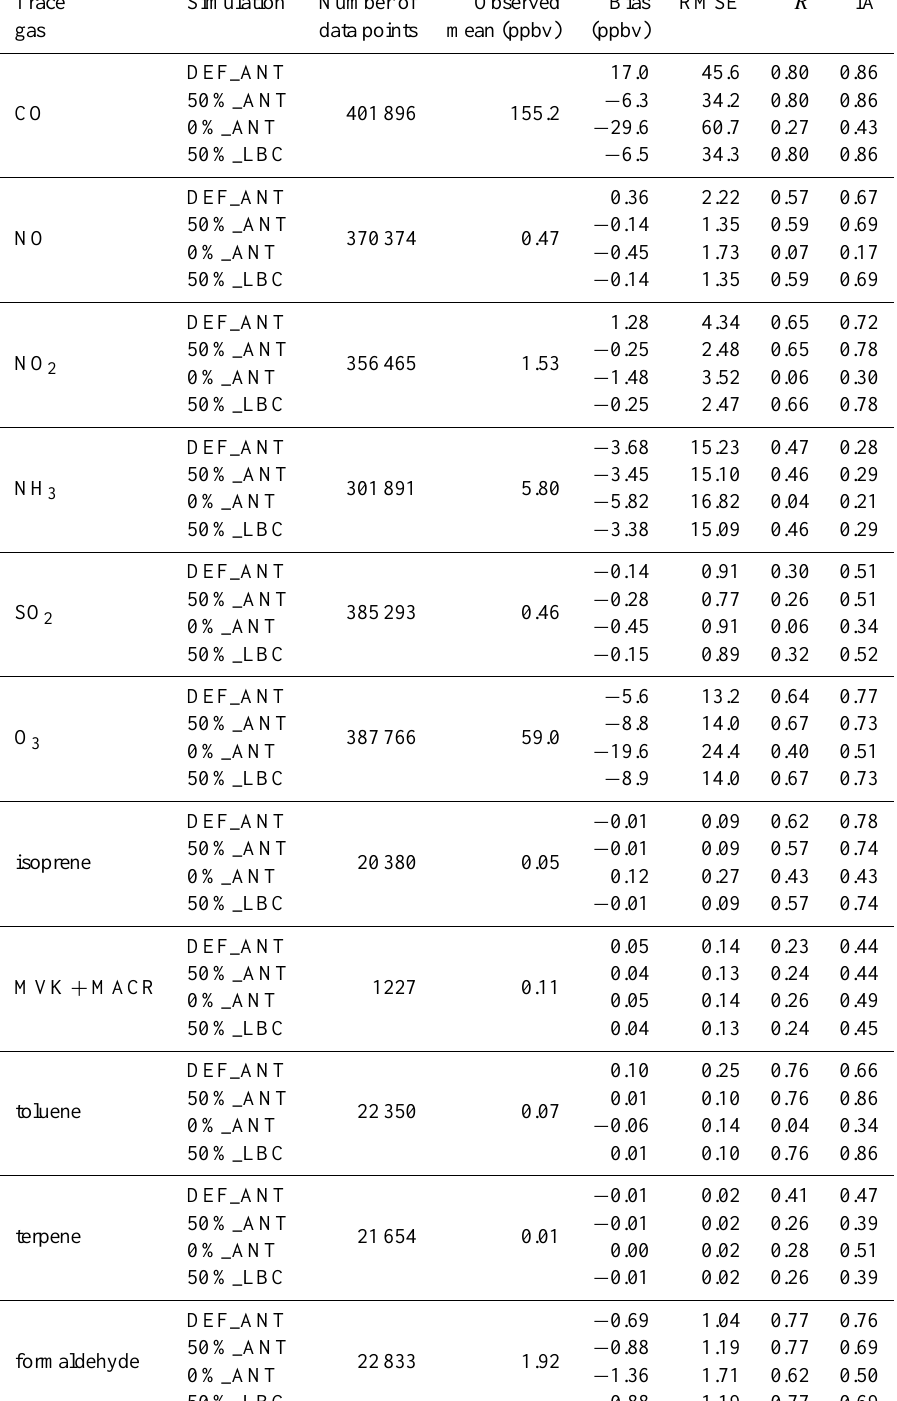
Table 9. Performance of simulated ozone (O 3 ) , carbon monoxide (CO), nitrogen oxide (NO), nitrogen dioxide (NO 2 ) , ammonia (NH 3 ) , sul- fur dioxide (SO 2 ) , isoprene, methyl-vinyl-ketone + methacrolein (MVK + MACR), toluene, terpene, and formaldehyde over all the WP-3D flights in terms of bias, root-mean-square error (RMSE), correlation coefficient ( R ), and index of agreement